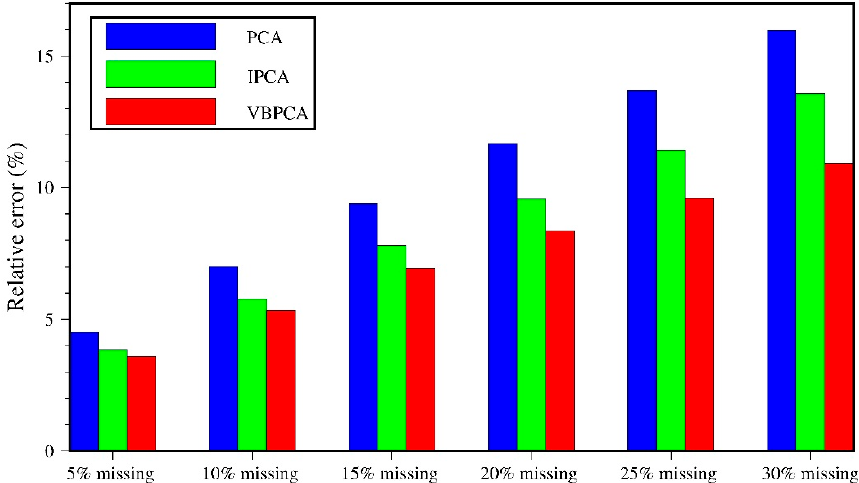
Figure 3. Relative errors of CME calculated by PCA (blue), IPCA (green), and VBPCA (red) with different percentages of deleted data.